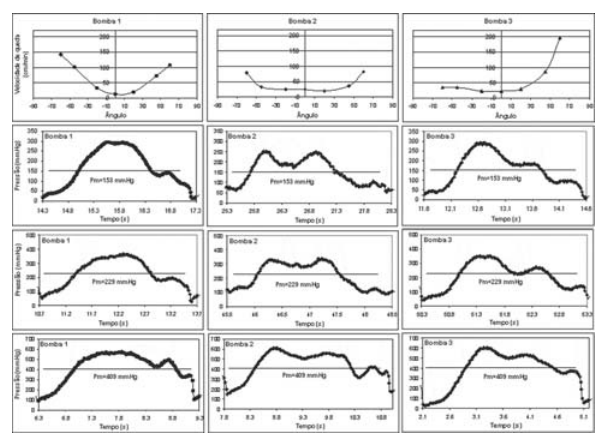
Fig. 4 – Perfis de velocidade de queda com respectivos diagramas de pressões durante a calibração dinâmica. Bombas 1, 2 e 3